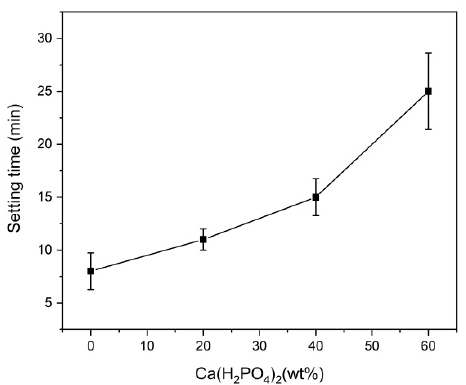
Figure 4. The setting time of BMPC specimens with Ca(H 2 PO 4 ) 2 .